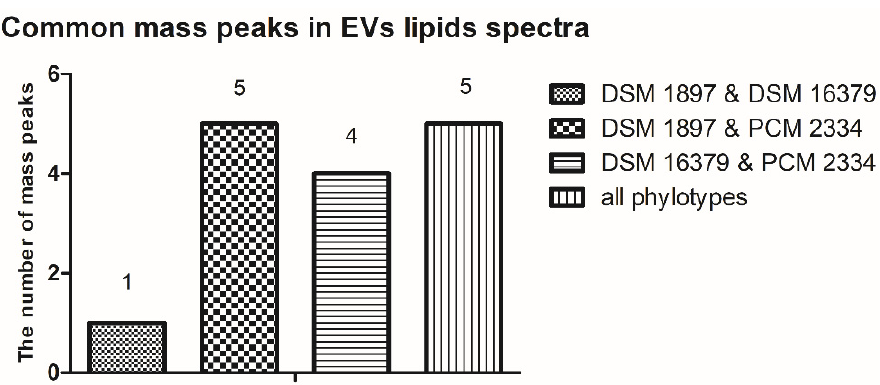
Figure 7. Comparison of the presence of common mass peaks of the vesicular lipids for the different C. acnes strains in MALDI-TOF MS analysis.